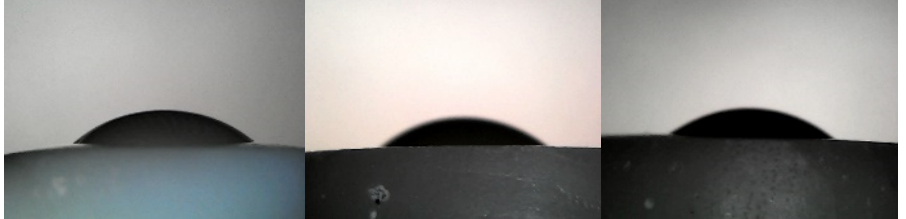
Figure 4. Droplets on the ( left ) enamel surface, ( middle ) glass-ionomer, and ( right ) composite ma- terial.